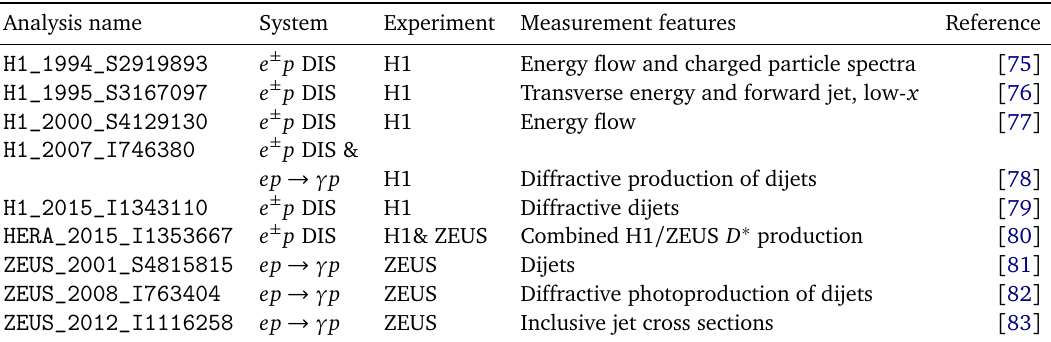
Table 2: All R IVET analyses routines available in a reasonable state of usability (though in general not formally validated). An up-to-date list can be found at https://rivet.hepforge.org